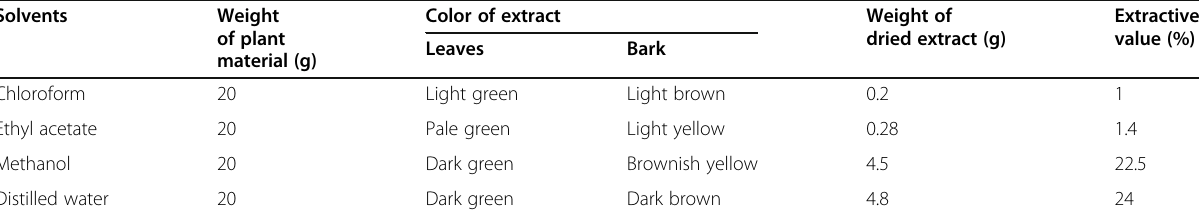
Table 3 Percentage of yield of different extracts of S . palghatense leaves and bark